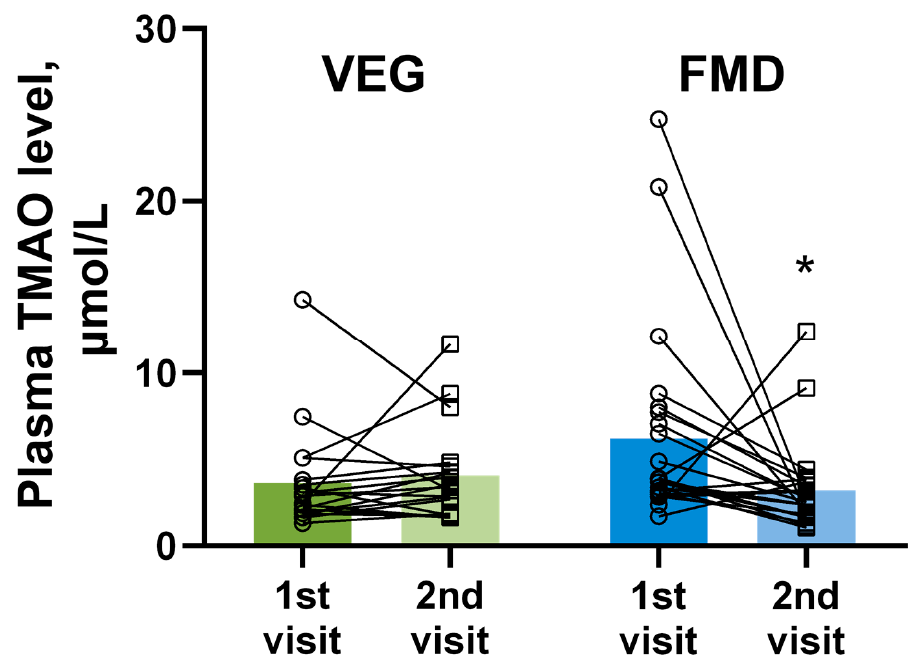
Figure 2. The impact of the 5-day cycle of regular diet supplemented with 4 servings of vegetables (VEG) and fasting-mimicking diet (FMD) on the plasma level of trimethylamine N-oxide (TMAO) in healthy volunteers. The results are presented as the mean and independent values of 19 volunteers in the VEG group and 24 volunteers in the FMD group. * Indicates a significant difference from the respective group at the 1st visit (Wilcoxon matched-pairs test), p < 0.05.